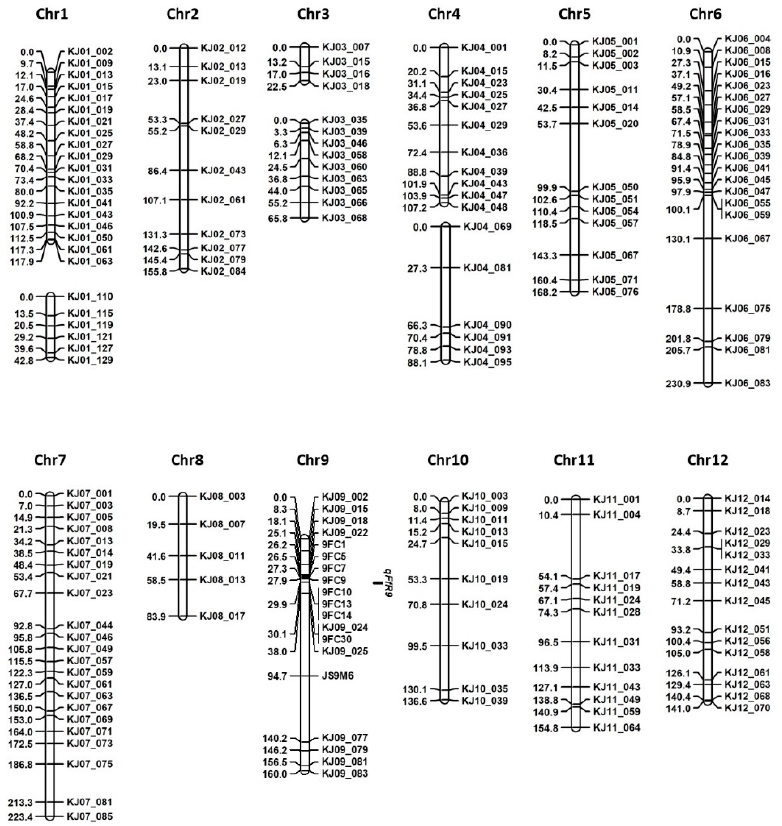
Figure 3. A genetic map constructed using kompetitive allele-specific PCR (KASP), cleaved amplified polymorphic sequence (CAPS), and derived CAPS (dCAPS) markers using F2 plants derived from crossing ‘Junam’ and ‘Samgwang’. The chromosome number is indicated at the top of each chromosome, the name of each marker is indicated at the right side of each chromosome, and the genetic distance of each marker from the first marker at the top of each chromosome is shown on the left side. Genetic distances, measured as centimorgan or cM, were calculated using the Kosambi function. In each chromosome, the linkage groups were separated where the distance between adjacent markers exceeded 50 cM. The quantitative trait locus (QTL) interval at 95% probability of qFfR9 is indicated by the filled black box.